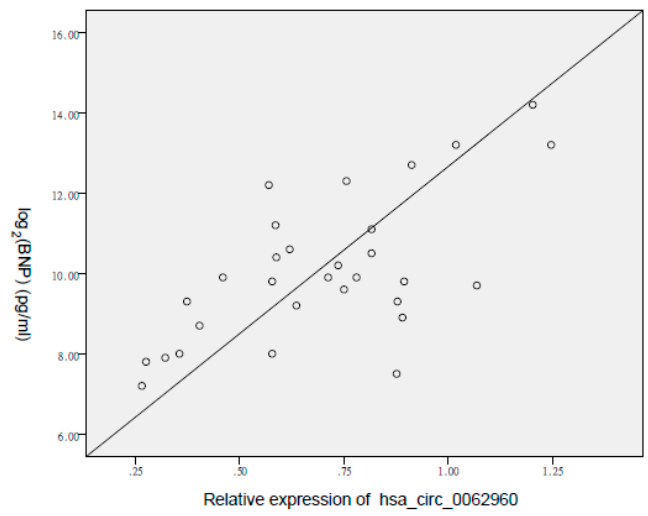
Figure 4. Correlation between the expression of hsa_circ_0062960 and serum brain natriuretic peptide (BNP) levels for patients with HF. BNP levels are displayed on a logarithmic scale. Pearson’s correlation is 0.649. The cohort included 30 patients with HF and 30 control individuals. Biomolecules 2020 , 10 , x FOR PEER REVIEW